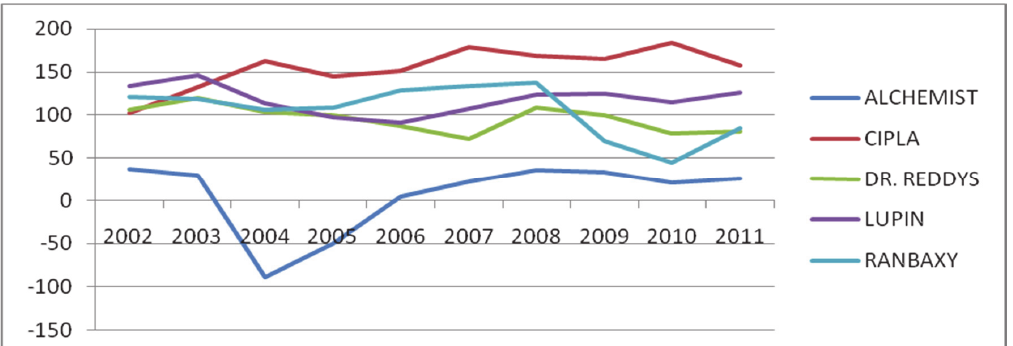
Fig. 1. Cash Conversion Cycle of Pharmaceutical Sector